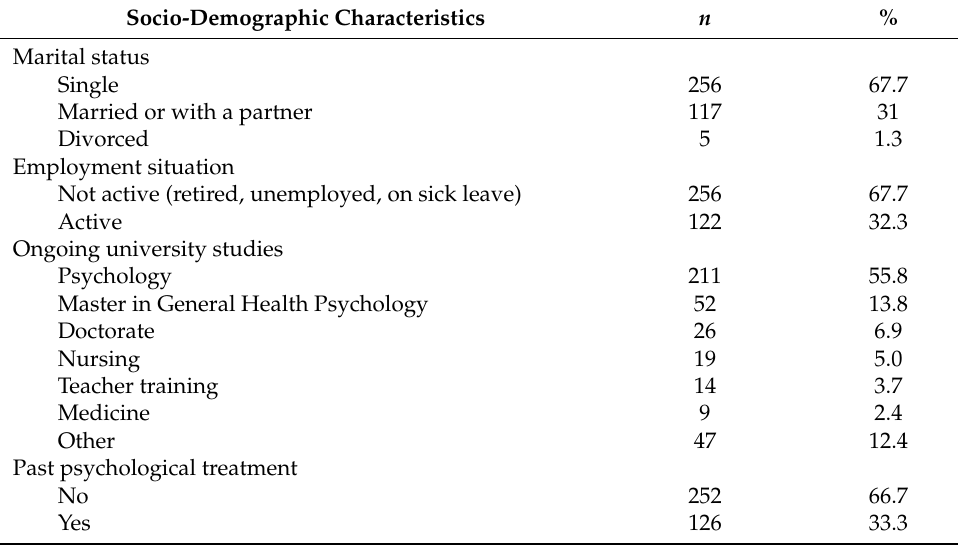
Table 1. Socio-demographic characteristics of the